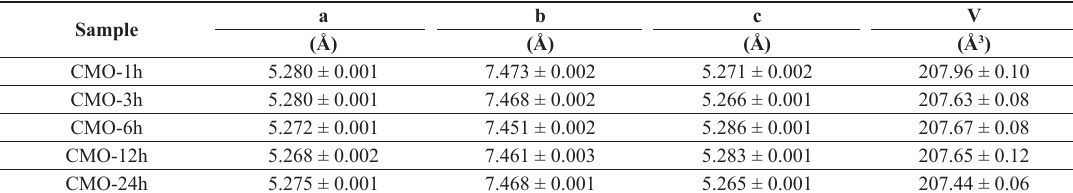
Table 1. Lattice parameters and cell volume for CMO ceramics sintered at different holding times.